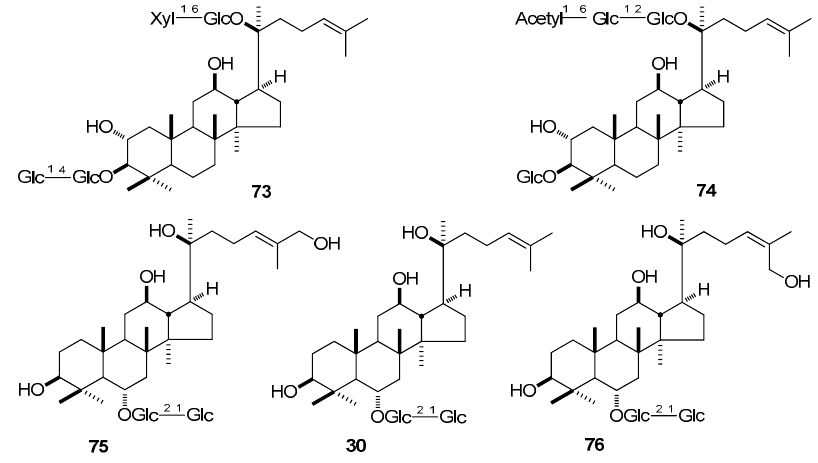
Figure 8. The structure of compounds 30 , 73 – 76 .